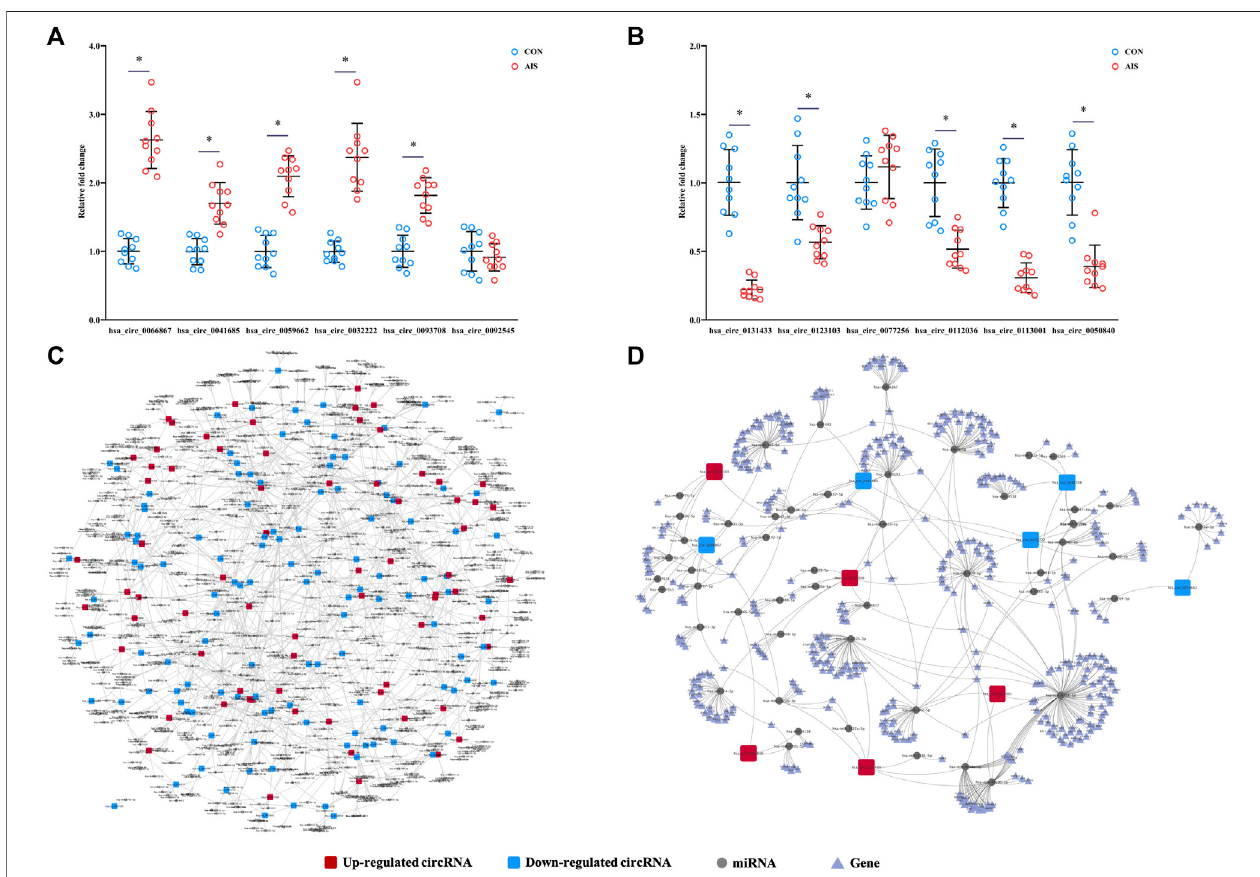
FIGURE5| Validationandnetworkdiagramofdifferentiallyquanti fi edcircRNAs. (A , B) Relativefoldchangesof12differentiallyquanti fi edcircRNAsusingqRT-PCR ( n = 10). *, p < 0.05. (C) Network of circRNA-miRNA of 198 differentially quanti fi ed circRNAs. (D) Network of circRNA-miRNA-mRNA of the 10 differentially quanti fi ed circRNAs veri fi ed by